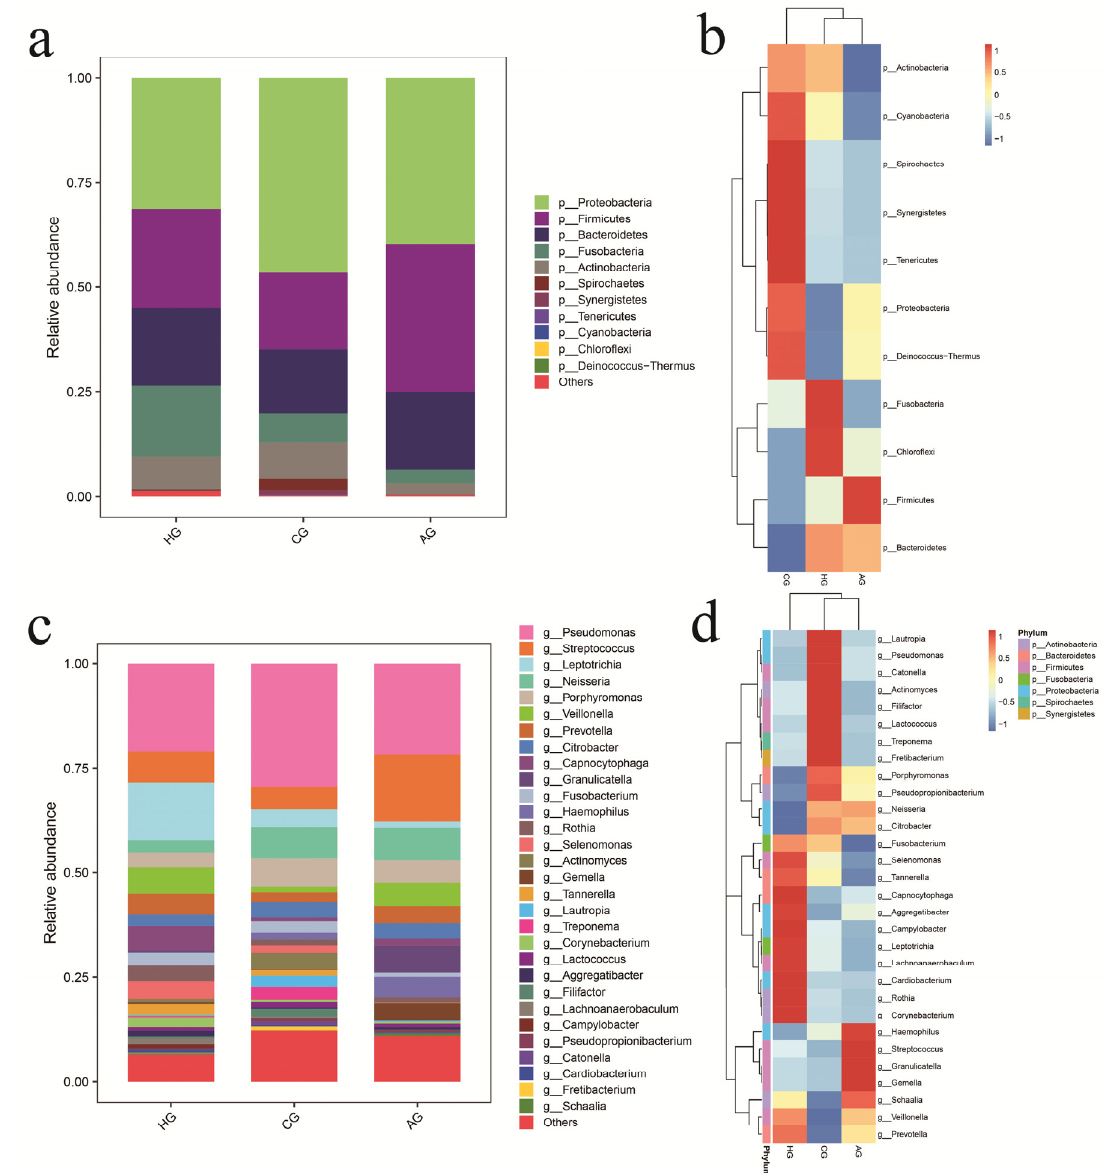
Figure 3. Histogram of species abundance at phylum ( a ) and genus ( c ) levels and heat map of species abundance at phylum ( b ) and genus ( d )